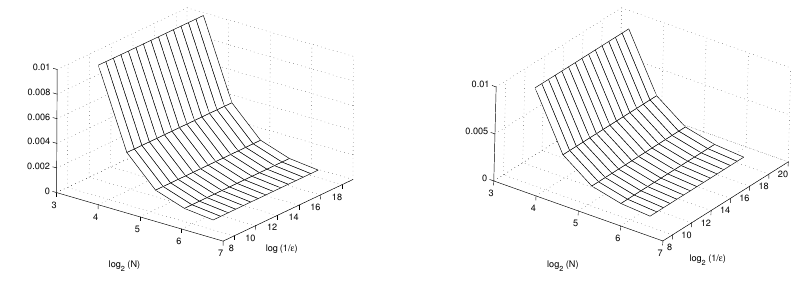
where (cid:101) Y 2048